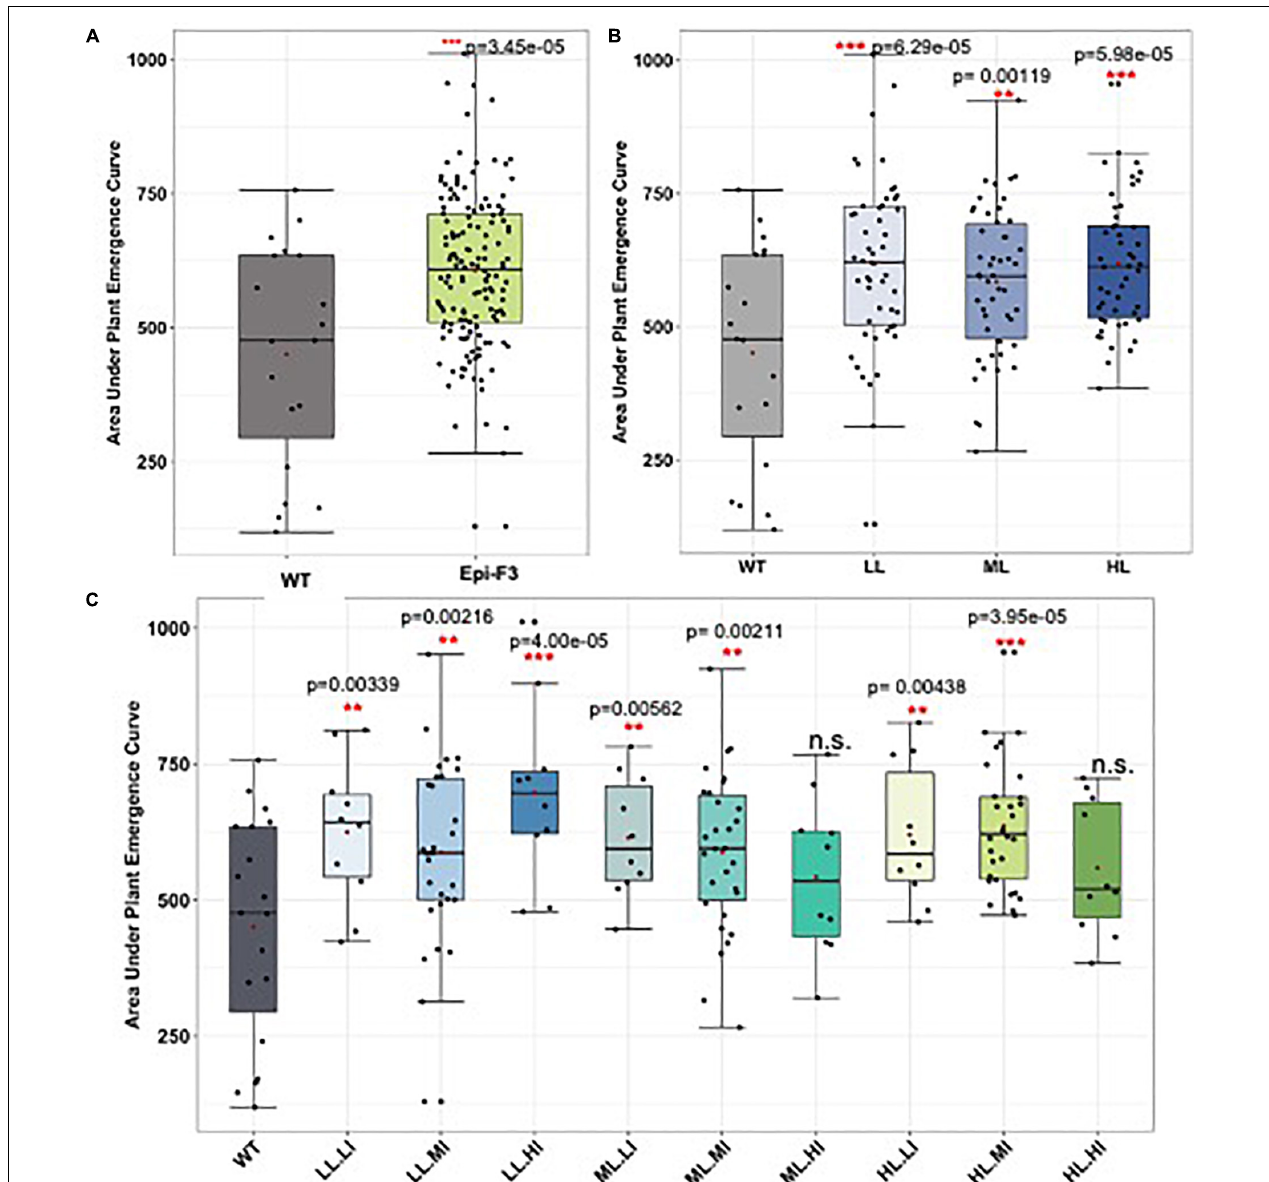
FIGURE 6 | Field cold stress seed germination experiment. A total of 150 epi-F3 and 19 wild-type sorghum Tx430 lines were tested in the field for germination rate under cold stress, with planting at Havelock over two seasons. Planting day soil temperature at 10 cm depth was 11.7 ◦ C for experiment 1 and 15.7 ◦ C for experiment 2. Standard plantings were carried out at Havelock Farm in mid-May (exp. 1) and mid-June (exp. 2) to assess optimal seed germination rates for each line. Each point represents the average of 2-year data for each line. Plant emergence (number of plants) was recorded on the following days after planting: days 13, 14, 15, 16, 17, 18, 20, 22, 25, 27, 32, 39, and 46. Adjusted emergence data from the early plantings were obtained by dividing early planting emergence by standard planting emergence. Area under the plant emergence curve (AUPEC) and emergence rates were calculated using the adjusted emergence data. Area under the plant emergence curve was calculated as: AUPEC = (cid:54) (cid:2)(cid:0) PE n + PE ( n + 1 ) (cid:1) / 2 (cid:3) ∗ Y ( n + 1 ) − Y n (cid:48) , Where PE n = plant emergence at time n , and Y n = day at time n . (A) Area under the plant emergence curve of all the 150 epi-F3 lines under cold stress were compared to the WT. (B) Area under the plant emergence curve of the WT compared to the epi-F3 groups, where epi-F3 populations are separated based on the line mean selection strategy used in the yield study. (C) Area under the plant emergence curve of the WT compared to the epi-F3 groups, where epi-F3 populations are separated based on the line mean and individual selection strategy used in the yield study. The least squares mean of each line was computed and a linear mixed-effect model was used for pairwise comparisons between each F3 line and the wild type. ∗∗ 0.001 < p -value < 0.01, and ∗∗∗ p -value < 0.001.